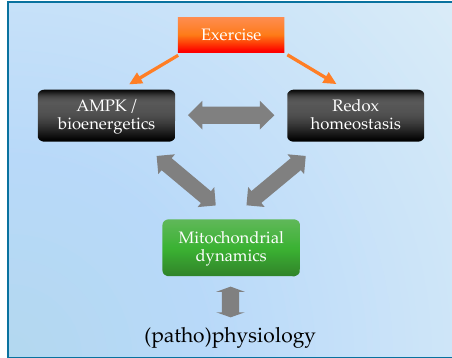
Figure 5. Proposed model for the interdependent regulation of mitochondrial dynamics in response to exercise.